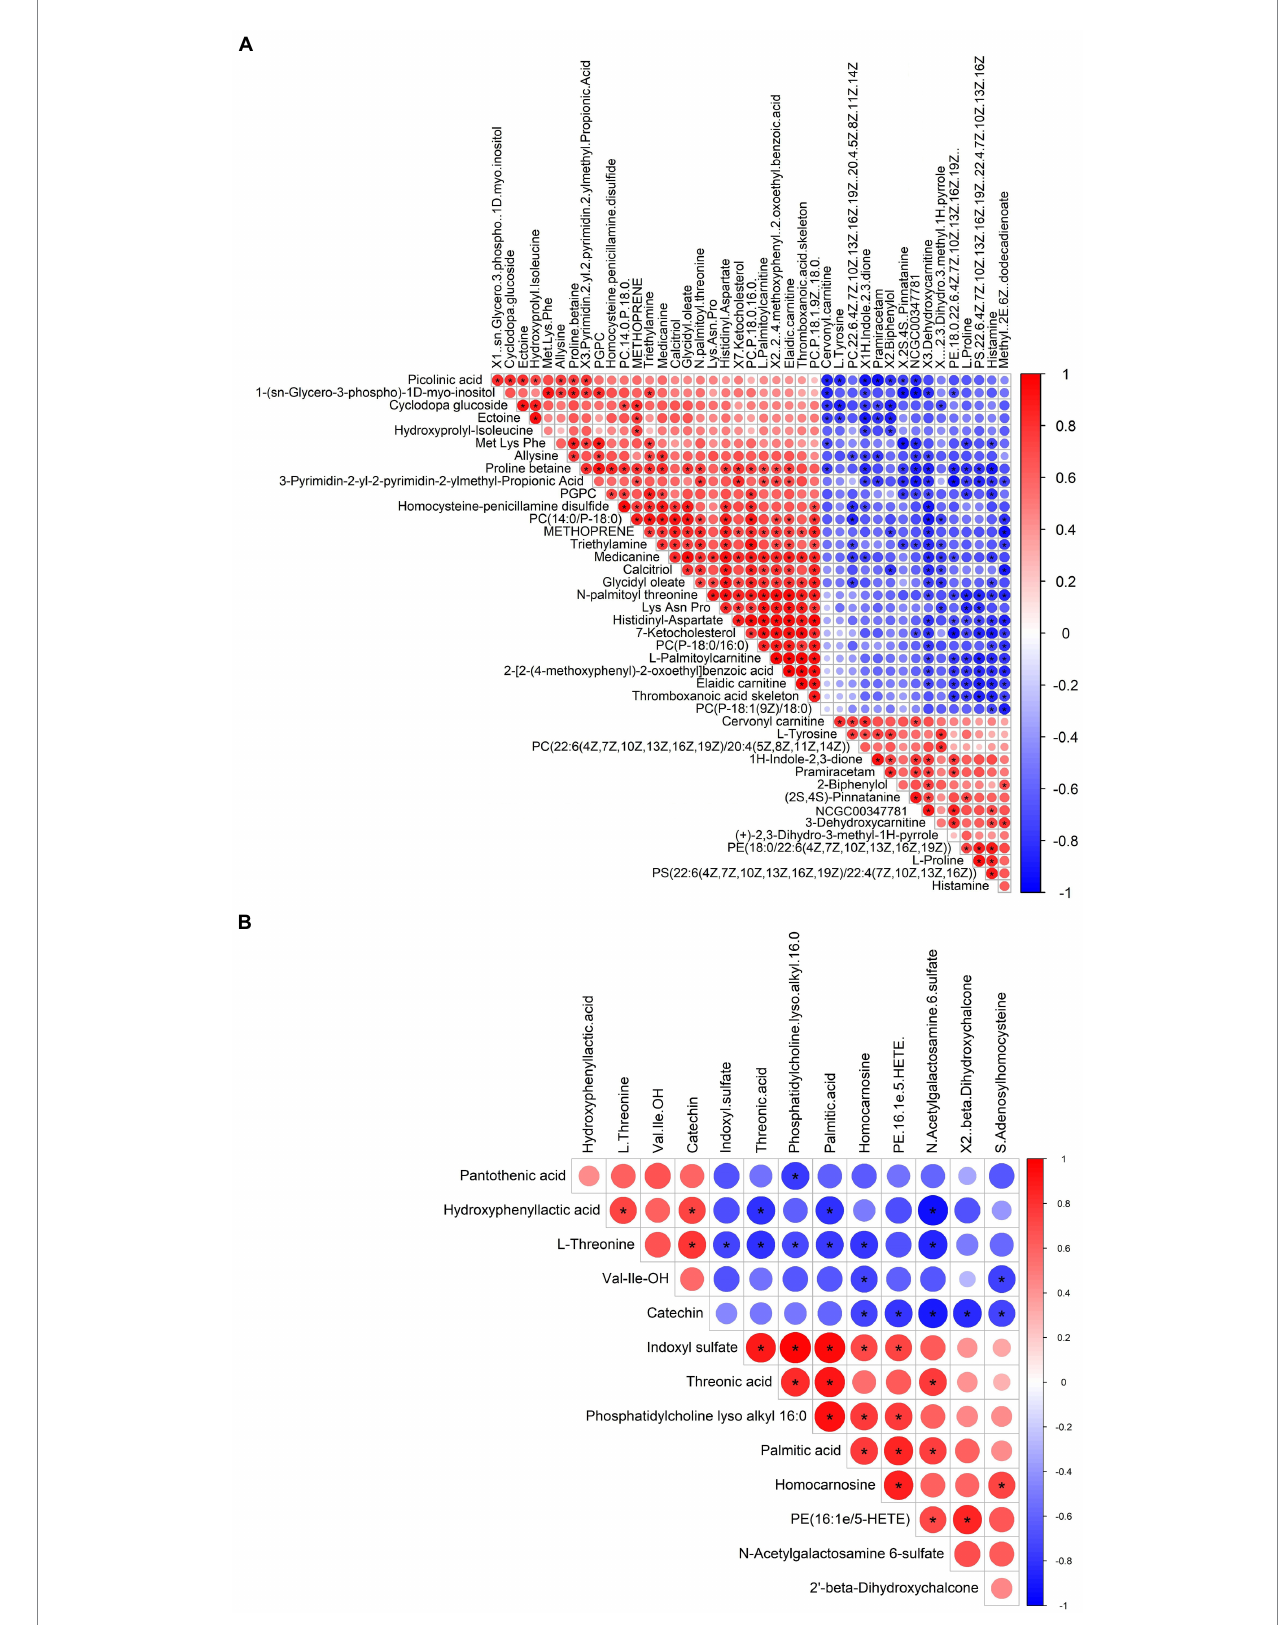
FIGURE 4 Heatmap of the correlation analysis for the SHR and WKY groups ( A : positive ion mode. B : negative ion mode). Red represents positive correlations, blue represents negative correlations, and darker colors represent stronger